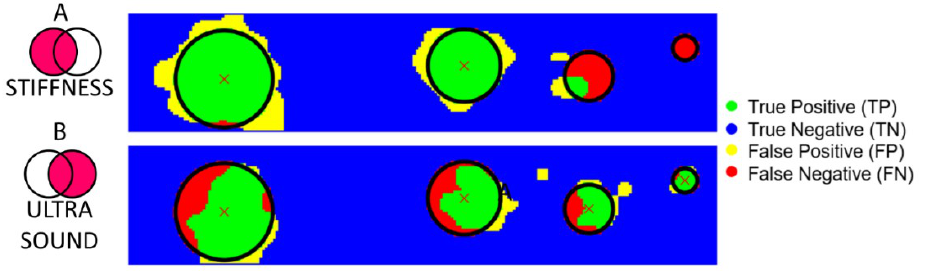
Figure 7. Classification (TP–TN–FP–FN) of all the points of the indentation matrix for the analyses with stiffness ( A ) and ultrasound ( B ) measurements.